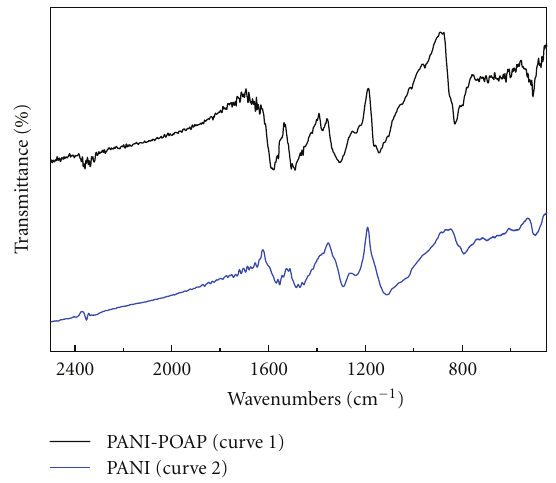
Figure 4: FTIR spectra of electrochemically synthesized PANI and PANI-POAP on an ITO electrode from 0.1 M ANI and 0.1M ANI + 0.001 M OAP solutions,